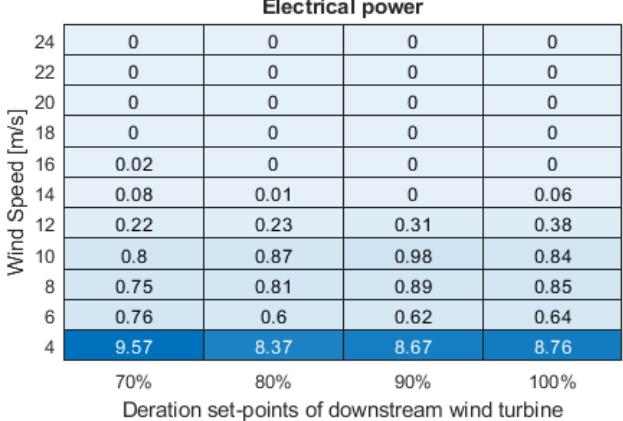
Figure 11. Test error of GPR for all DELs of different deration set-points of downstream wind turbines at I ref = 0.14 with operating upstream wind turbine at 90%. The model was trained and tested in an input data set that does not contain input data of I ref = 0.12,0.14,0.16 and downstream wind turbines at 70%, 80%, 90% and 100%.